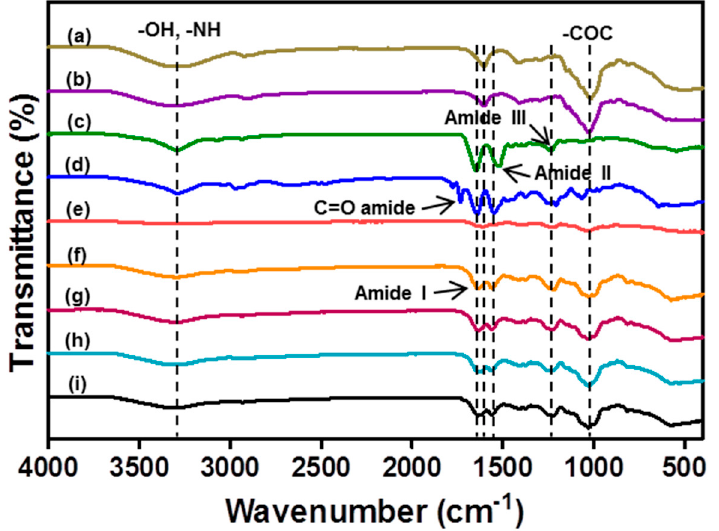
Figure 1. FT-IR evaluation of GG (a), ionic crosslinked GG (b), pristine SF (c), EN-SF (d), CS (e), 0.3% GG/3.7% SF/CS (f), 0.5% GG/3.5% SF/CS (g), 0.75% GG/3.25% SF/CS (h), and 1% GG/3% SF/CS (i) analyzed at the wavelength range of 400–4000 cm ⁻ 1 .